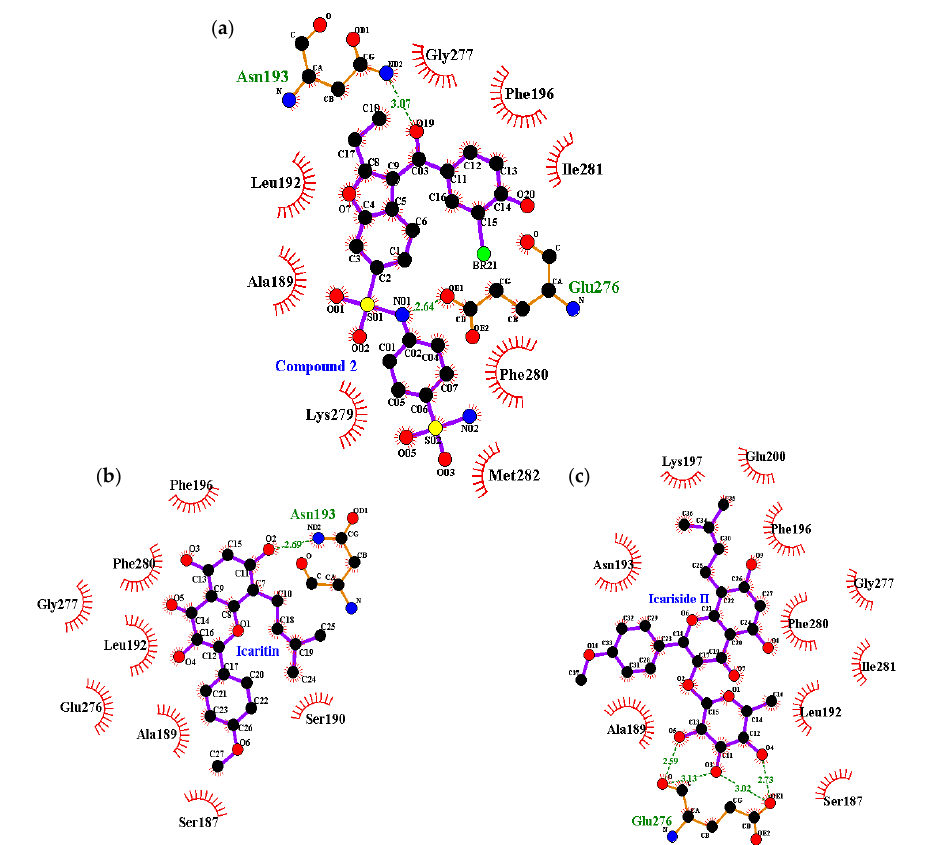
Figure 5. Molecular docking models for PTP1B inhibition of: ( a ) compound 2 ; ( b ) icaritin; and ( c ) icariside II.